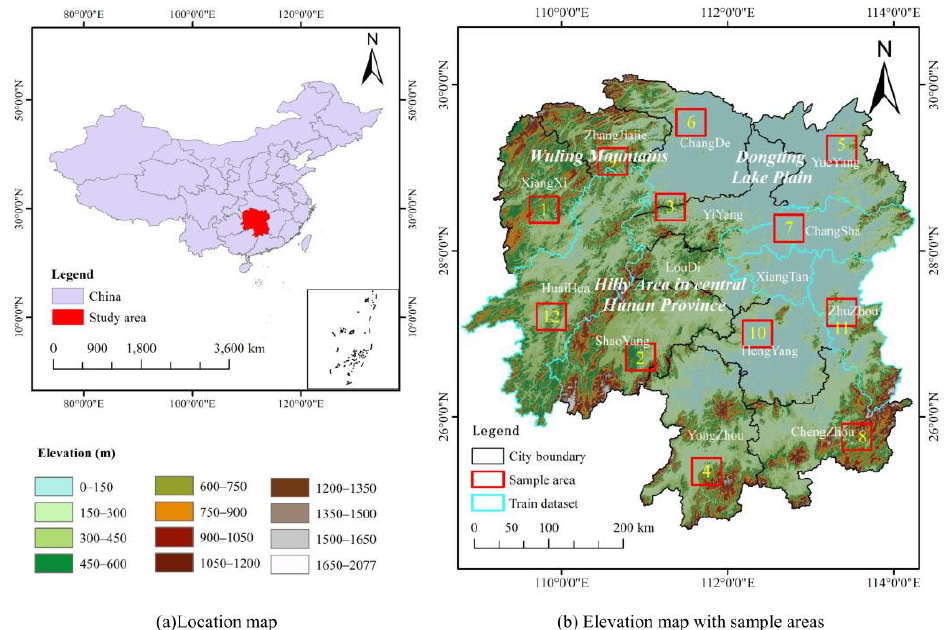
Figure 1. ( a ) The location of the study area. The full extent of the study area is the satellite image coverage area used for this experiment. ( b ) The Elevation map of the study area and the location of the sample area distribution. The “train dataset” in the figure is where the training samples are collected.